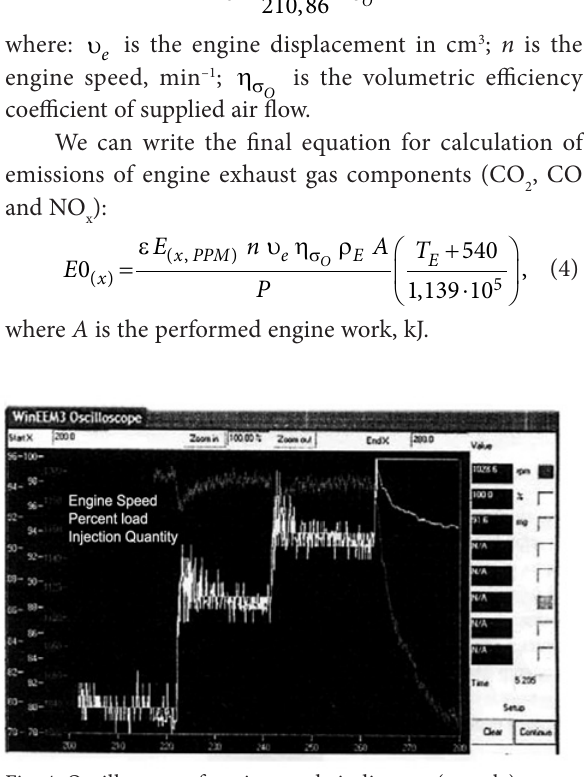
Fig. 4. Oscillogram of engine mode indicators (sample)